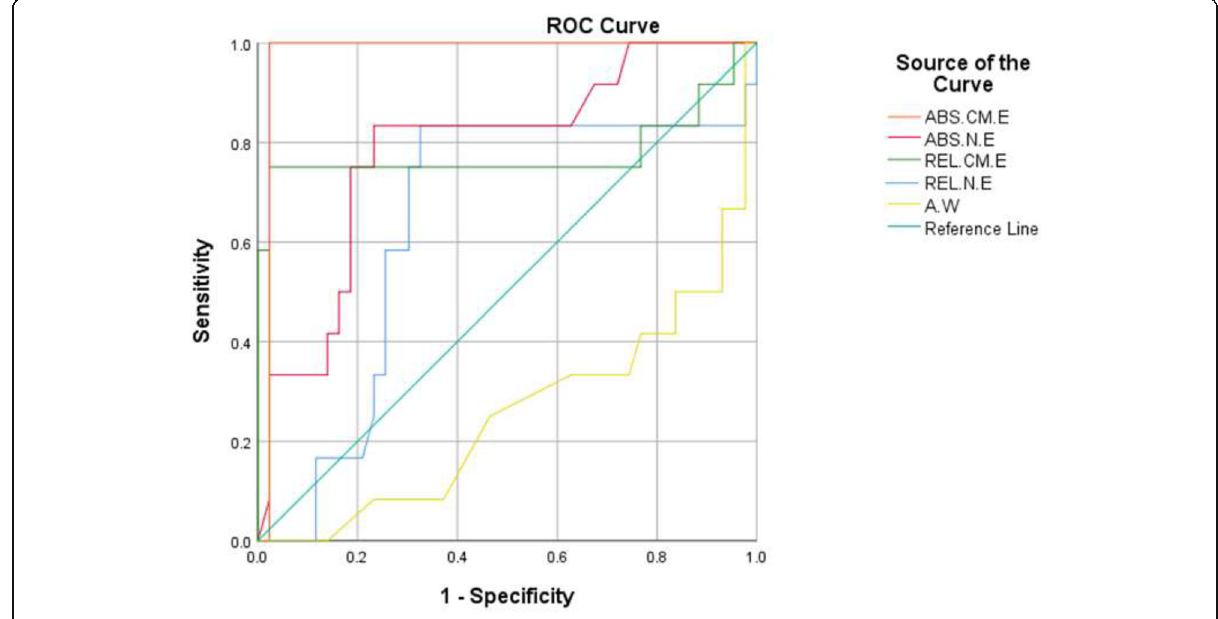
Fig. 2 ROC curves for parameters of dynamic study in differentiation between clear cell RCC and non-clear cell RCC